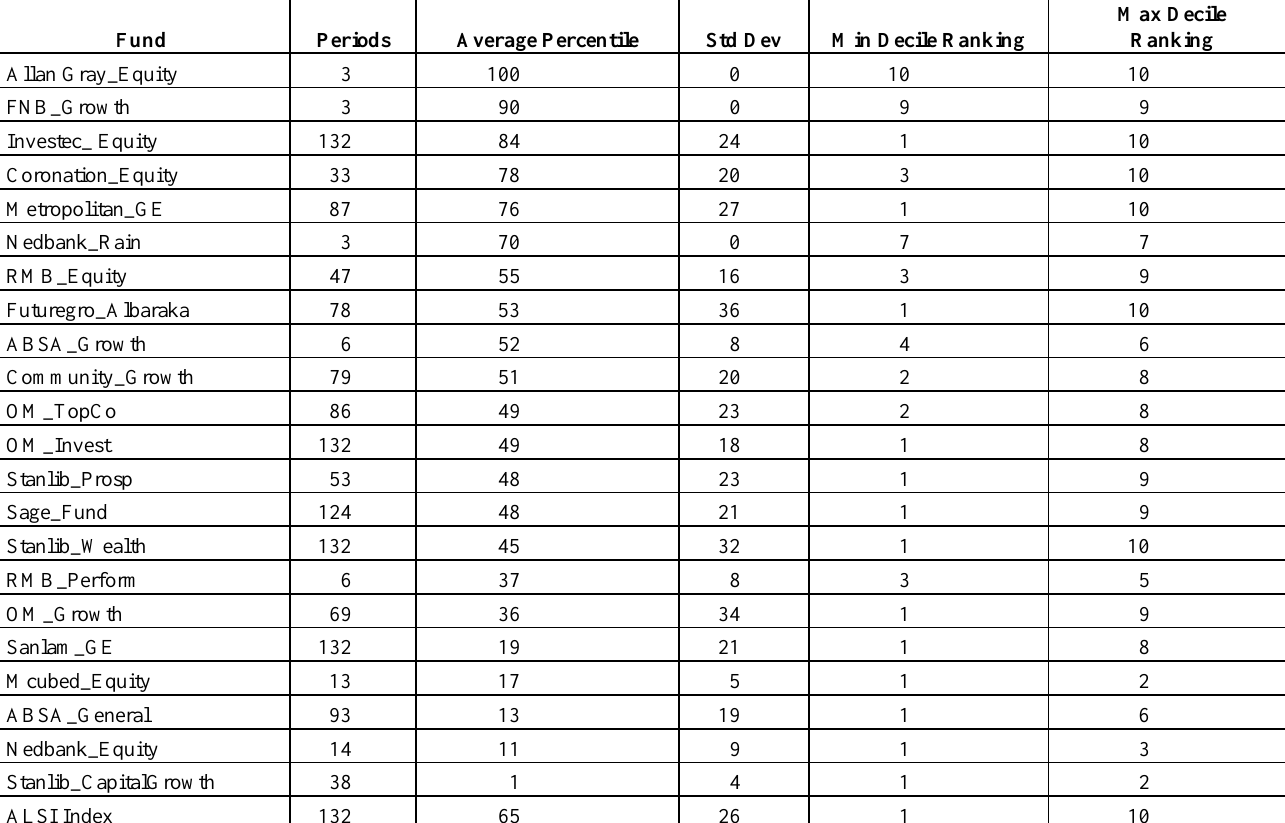
Table 2: Percentile ranking of actively managed funds over rolling 60-month investment period s